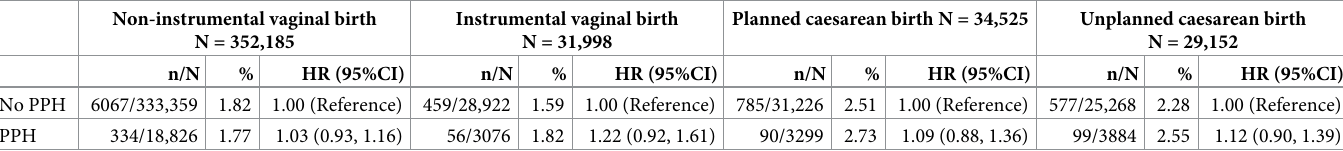
Table 2. Adjusted Hazard Ratios for postpartum depression after exposure to postpartum hemorrhage (PPH). Non-instrumental vaginal birth N =